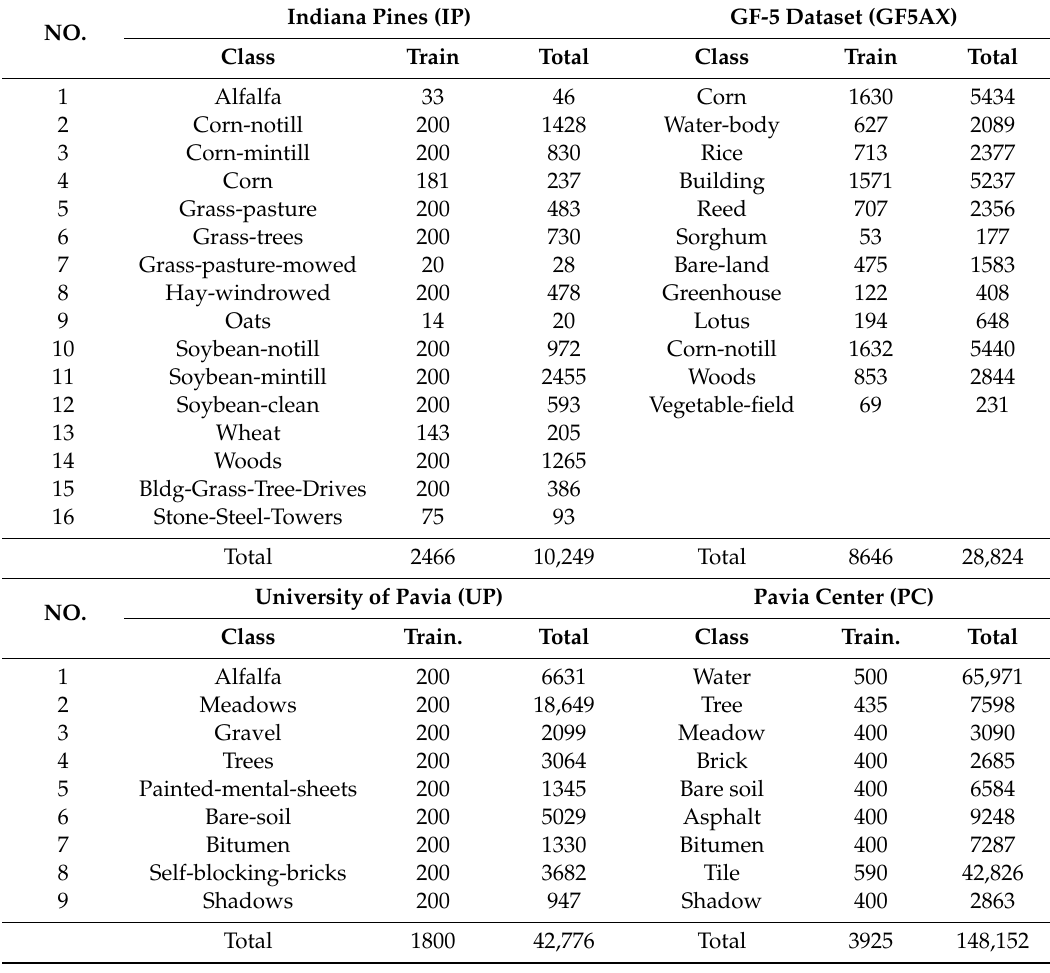
Figure 4. Indiana Pines dataset: ( a ) false-color composite of Indiana Pines, ( b ) ground-truth map. Table 1. Number of training samples used in the Indiana Pines dataset.